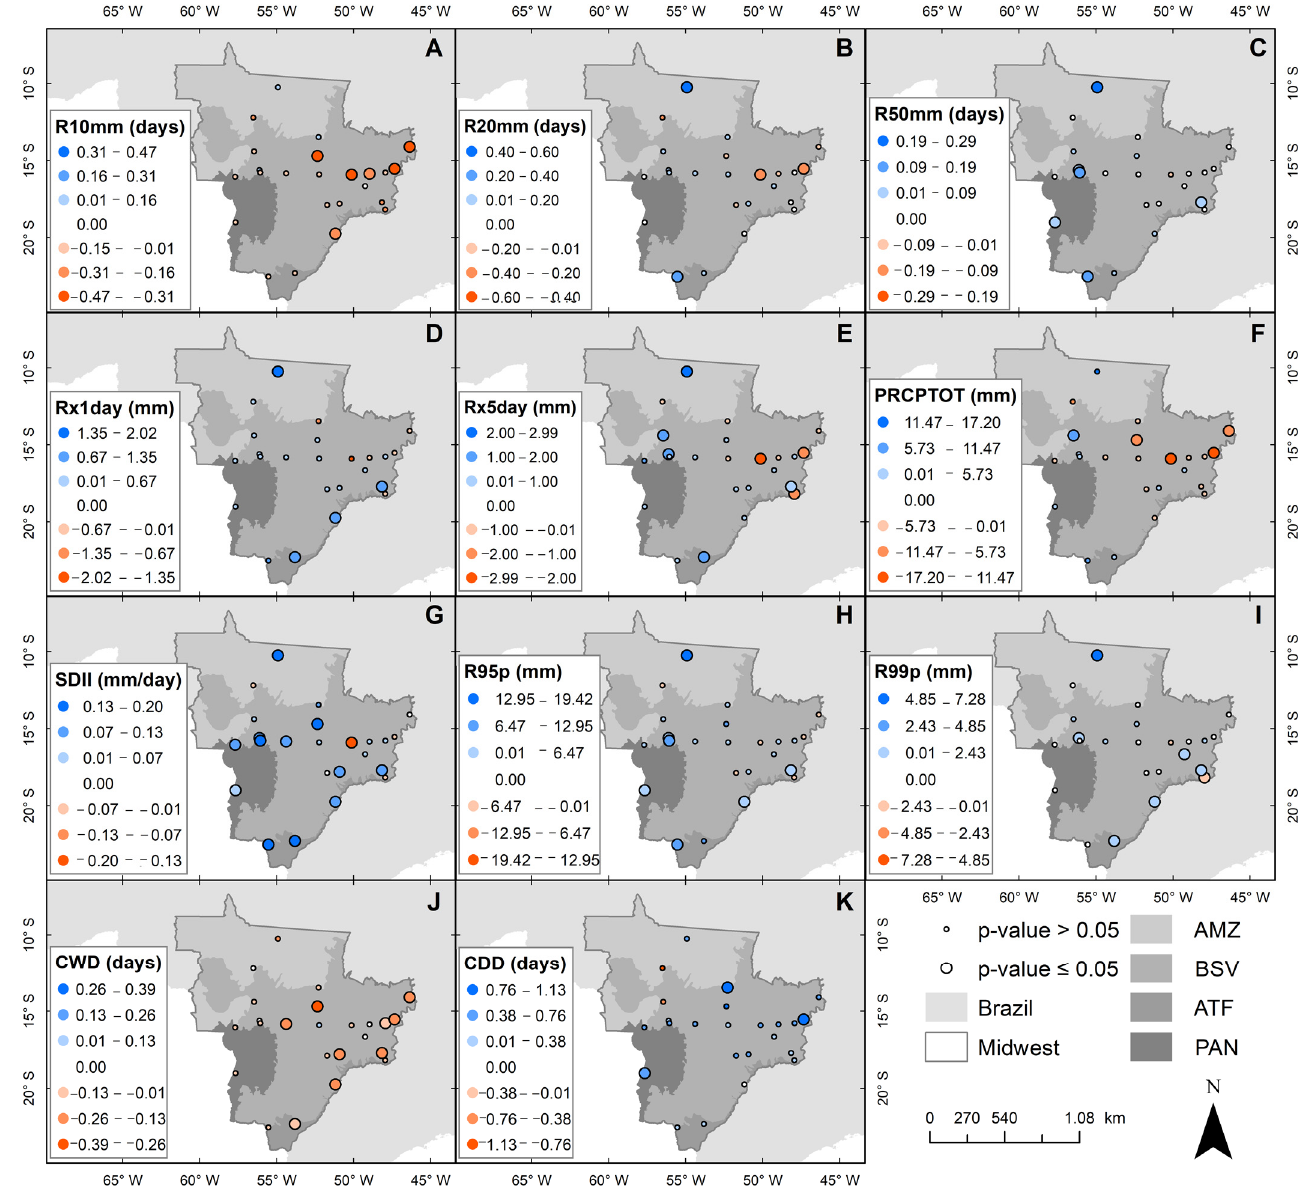
Figure 2. Spatial distribution of trends regarding number of heavy precipitation days (R10mm) ( A ), number of very heavy precipitation days (R20mm) ( B ), number of days above 50 mm (R50mm) ( C ), maximum 1-day precipitation amount (Rx1day) ( D ), maximum 5-day precipitation amount (Rx5day) ( E ), annual total wet day precipitation (PRCPTOT) ( F ), simple daily intensity index (SDII) ( G ), precipitation on very wet days (R95p) ( H ), precipitation on extremely wet days (R99p) ( I ), consecutive wet days (CWD) ( J ), and consecutive dry days (CDD) ( K ) in Midwest Brazil from 1979 to 2019. Large circles indicate statistical significance at the 5% level and small circles are not